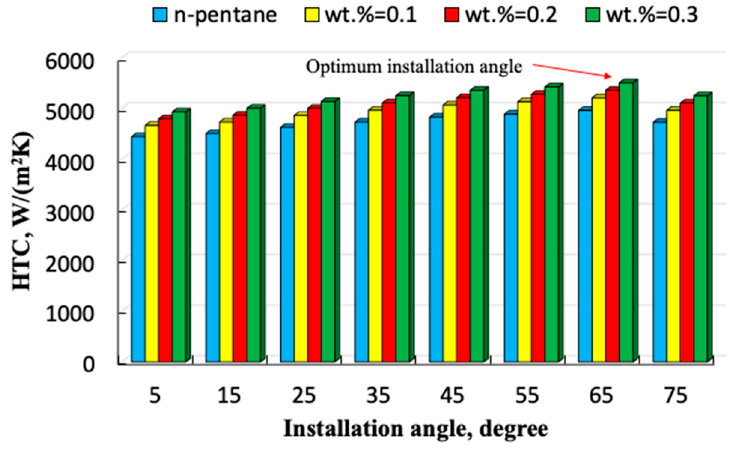
Figure 7. Variation of the HTC with the installation angle of the HP for pure n-pentane and nanofluids.